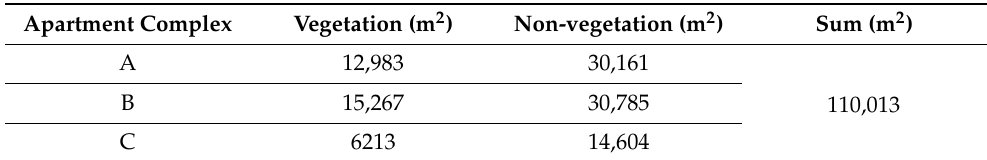
Table 8. Vegetation area by apartment complex analyzed by combining NDVI and thermal infrared image.